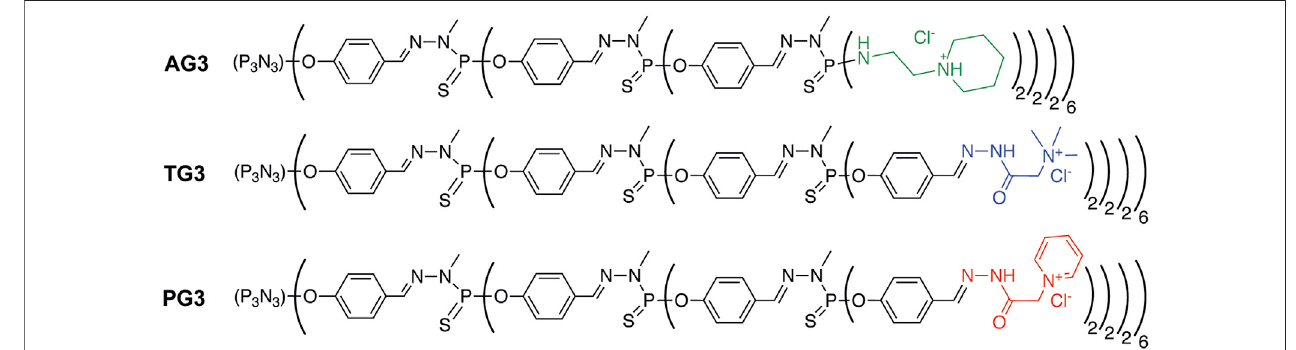
FIGURE 1 | Structures of polycationic phosphorus dendrimers used for preparing